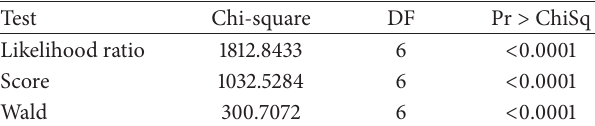
Table 7: Analysis of maximum likelihood estimates.